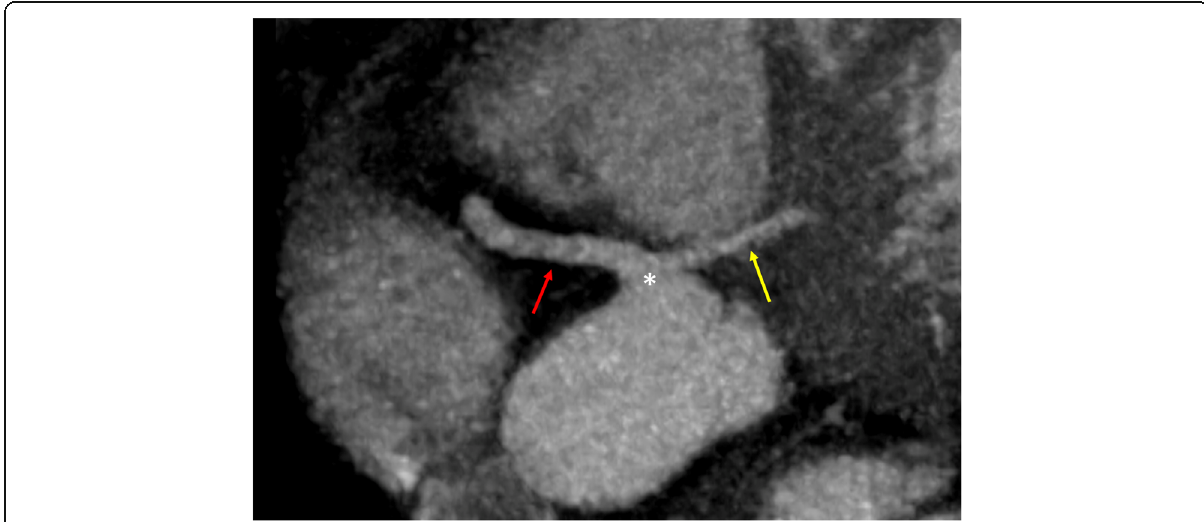
Fig. 1 CCT MPR showing the right (red arrow) and left (yellow arrow) coronary arteries originating from the right coronary ostium